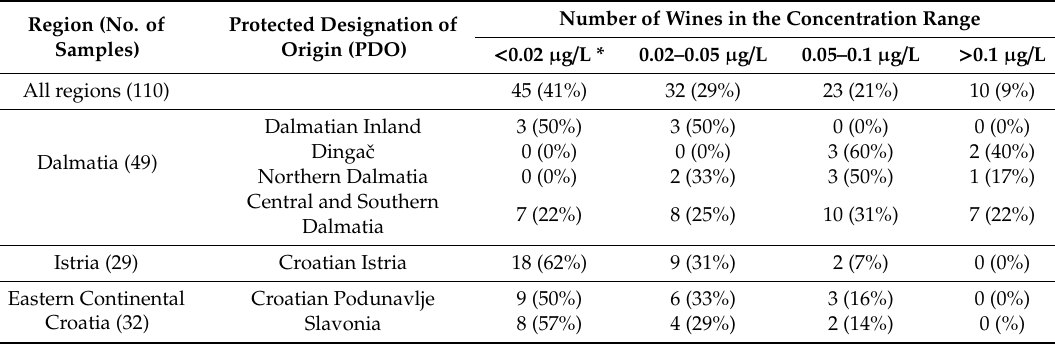
Table 4. Prevalence of measured concentrations of OTA according to geographic